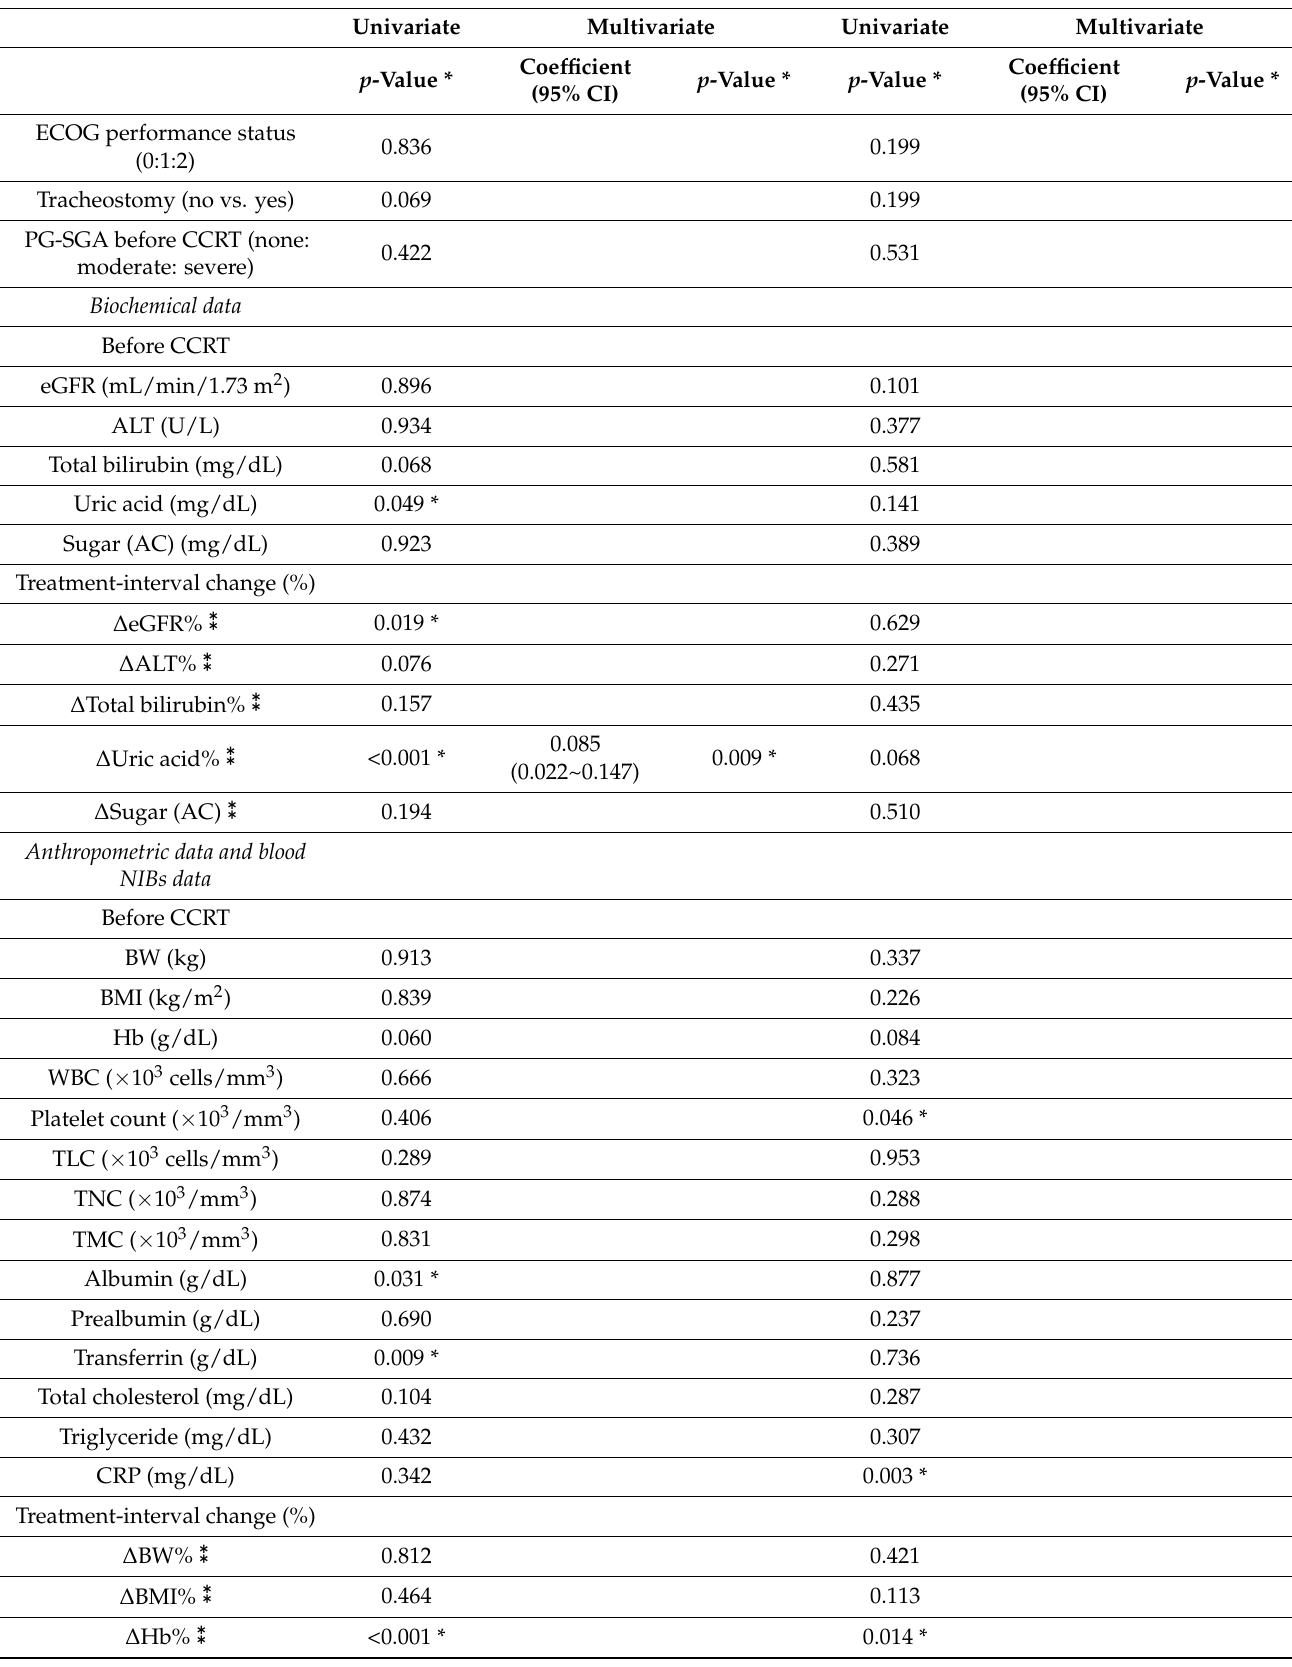
Table 1. Clinicopathological variables, biochemical and nutrition–inflammation data, anthropomet- ric and body composition characteristics, serum HLOP metabolites, and treatment-related factors of 44 patients with LAHNSCC completing the CCRT course, stratified by treatment interruption.